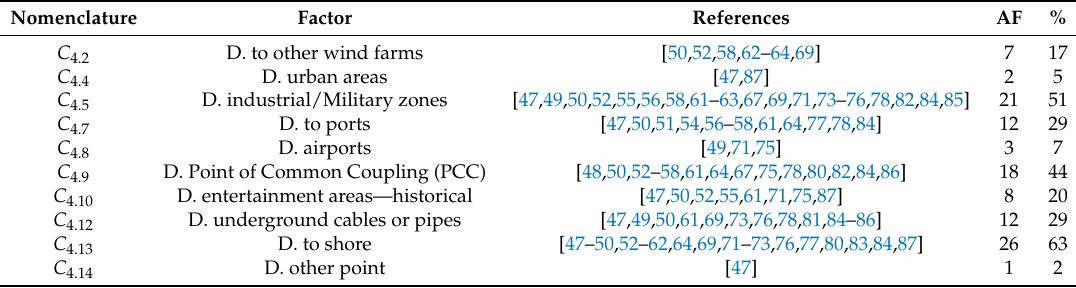
Table 16. Location Category ( C 4 )—Offshore wind energy. Quantitative